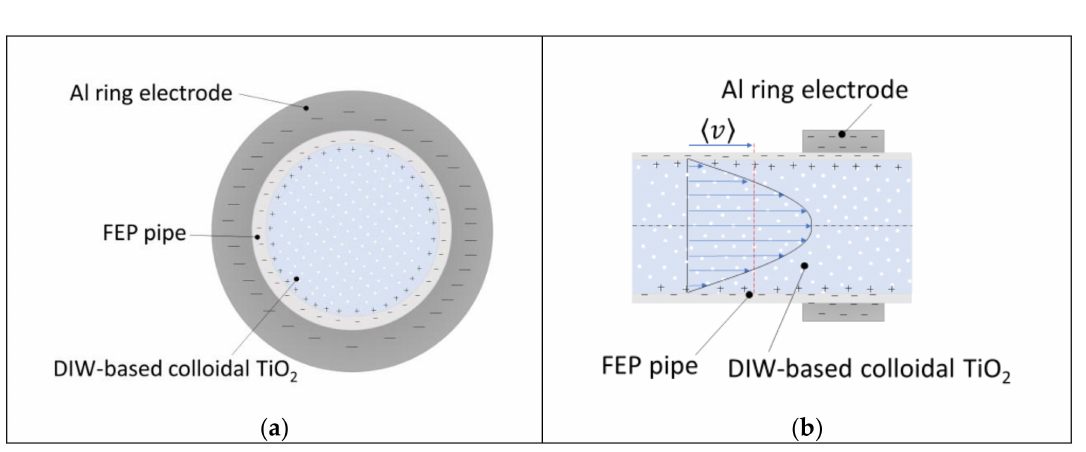
Figure 7. Representation of triboelectric phenomenon in cross section ( a ) and lateral section ( b )